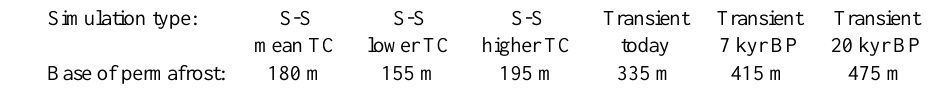
Table 5. Depth of permafrost base for the different simulations at borehole 5011-3. S-S is steady-state. Simulation type: S-S S-S S-S Transient Transient Transient higher TC Base of permafrost: 180 m 475 m